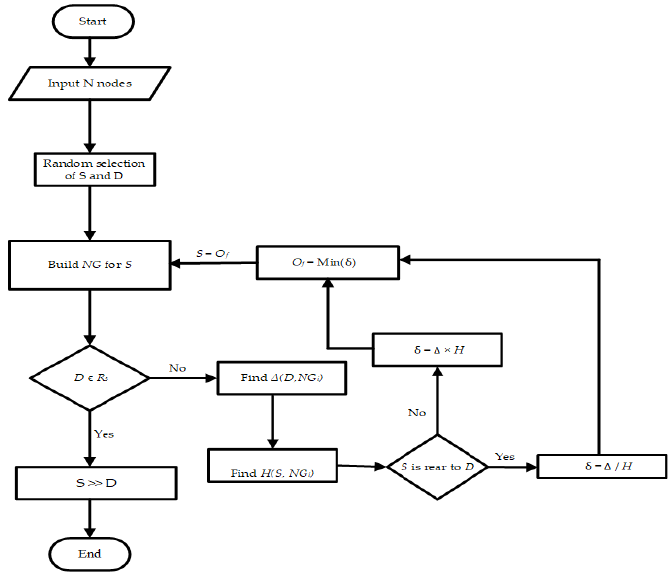
Figure 2. An overview of the OPRP.